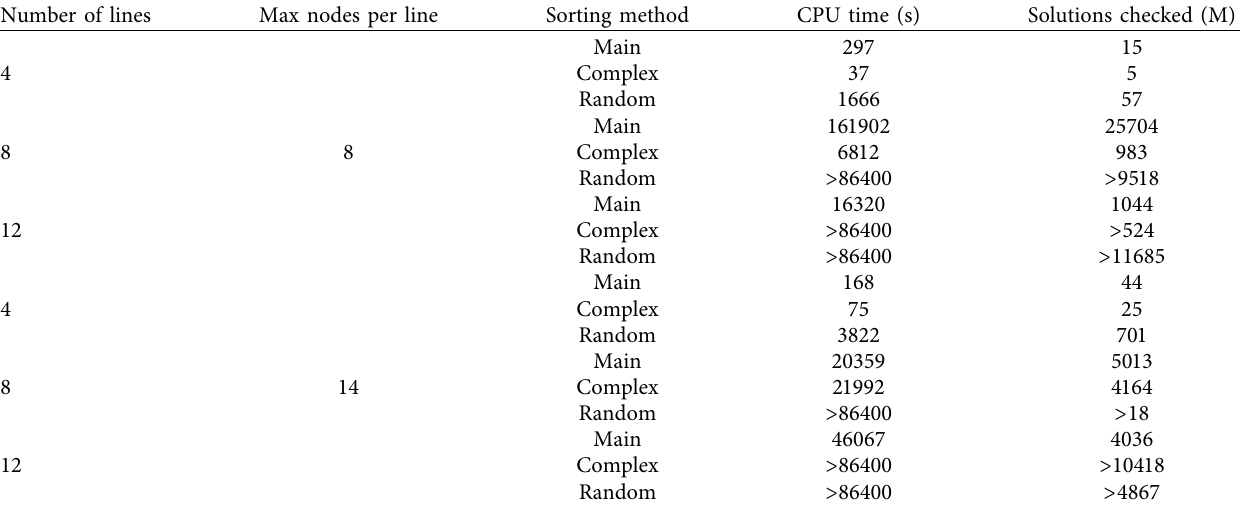
Table 7: Impact of different sorting methods on the exact algorithm.